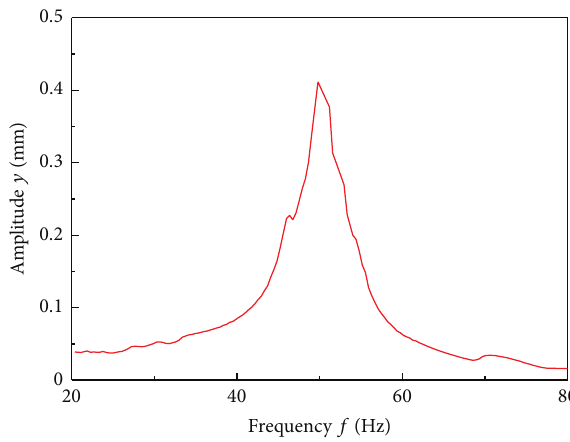
Figure 11: Experimental setup: the photo.